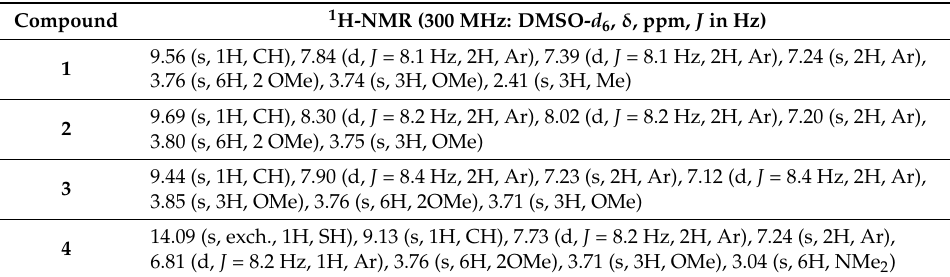
Table 2. 1 H-NMR spectral data for Schiff bases 1 – 4 .